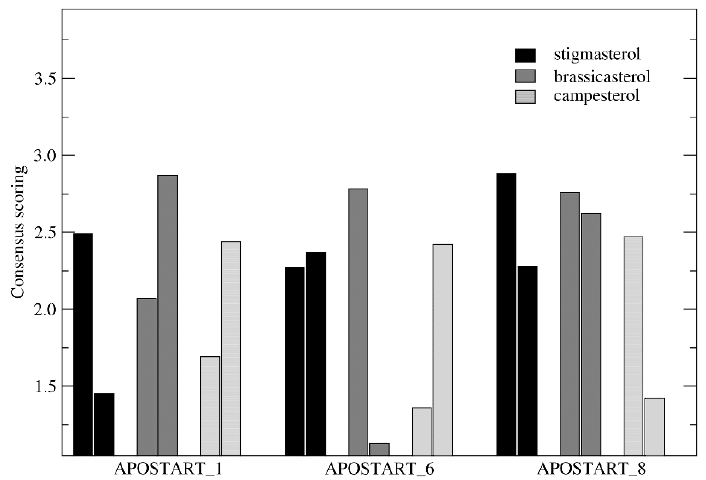
Figure 6. Consensus scoring of stigmasterol (black), brassicasterol (dark gray), and campesterol (light gray) poses binding at APOSTART_1 (left), APOSTART_6 (middle), and APOSTART_8 (right) obtained after 500 ps of MD (Molecular Dynamics) simulation (vide infra).